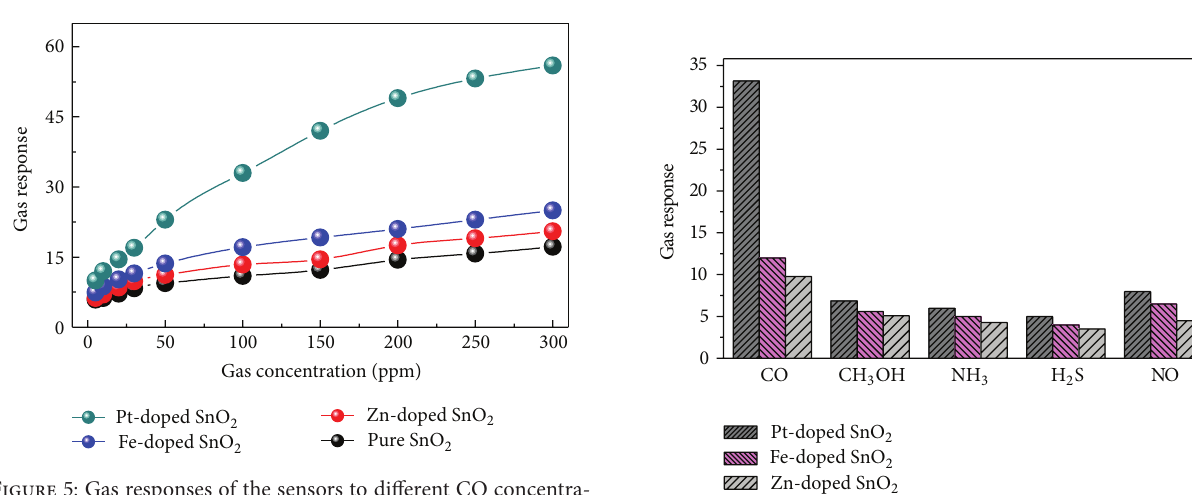
Figure 7: Stability and repeatability of the sensors to 100ppm of CO.